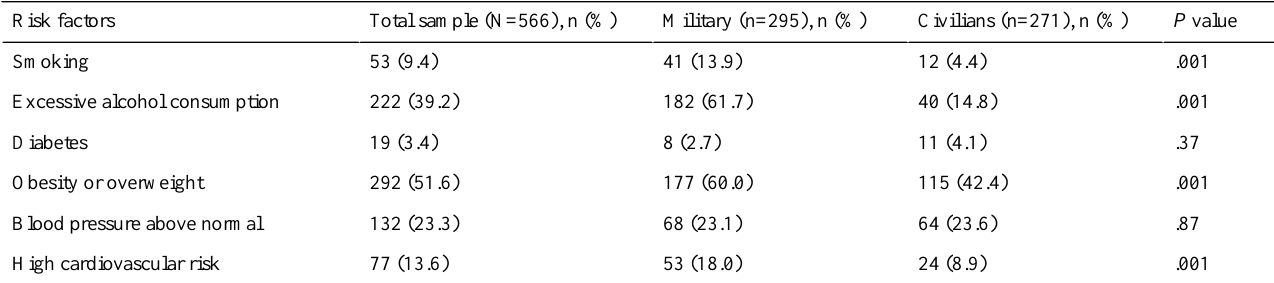
Table 2. Distribution of cardiovascular risk factors in the sample population.